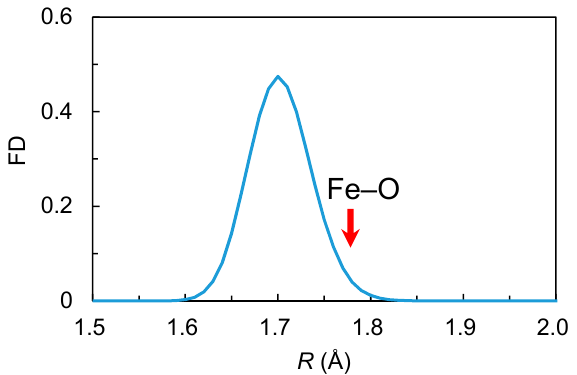
Figure 3. Frequency distribution of O atoms around Al in γ -LiAlO 2 :Fe 3+ . The red arrow indicates the averaged Fe–O distance observed in the relaxed structure after MD.